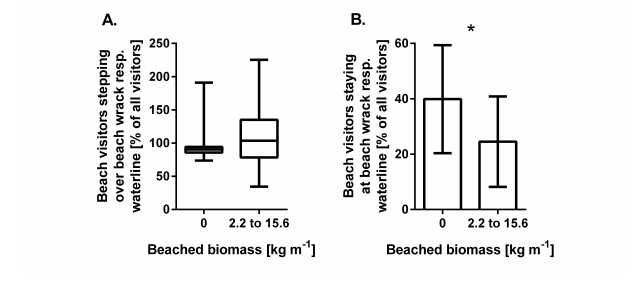
Fig. 6 . Effect of Zostera beach wrack absence compared to presence at densities between 2.2 and 15.6 kg m-1 on (A.) the frequency of beach visitors crossing the beach wrack and (B.) the frequency of these visitors staying in direct vicinity of the beach wrack for 30 s or more time. Alltogether 118 repeated measurements were conducted in time intervals of 30 min on six different beach sections and biomass densities were determined in parallel (see Fig. S1 for the complete data set). Data shown here represent measurements in absence of beach wrack (n = 22) and measurements with presence of beach wrack at the highest densities (n = 22). Median ± quartiles is shown in (A.), while average ± SD is shown in (B.). Asterisks indicate pairs of groups that are significantly different (p < 0.05; tested with Mann-Whitney-U-test in (A.) and with Welsh- corrected t-test in